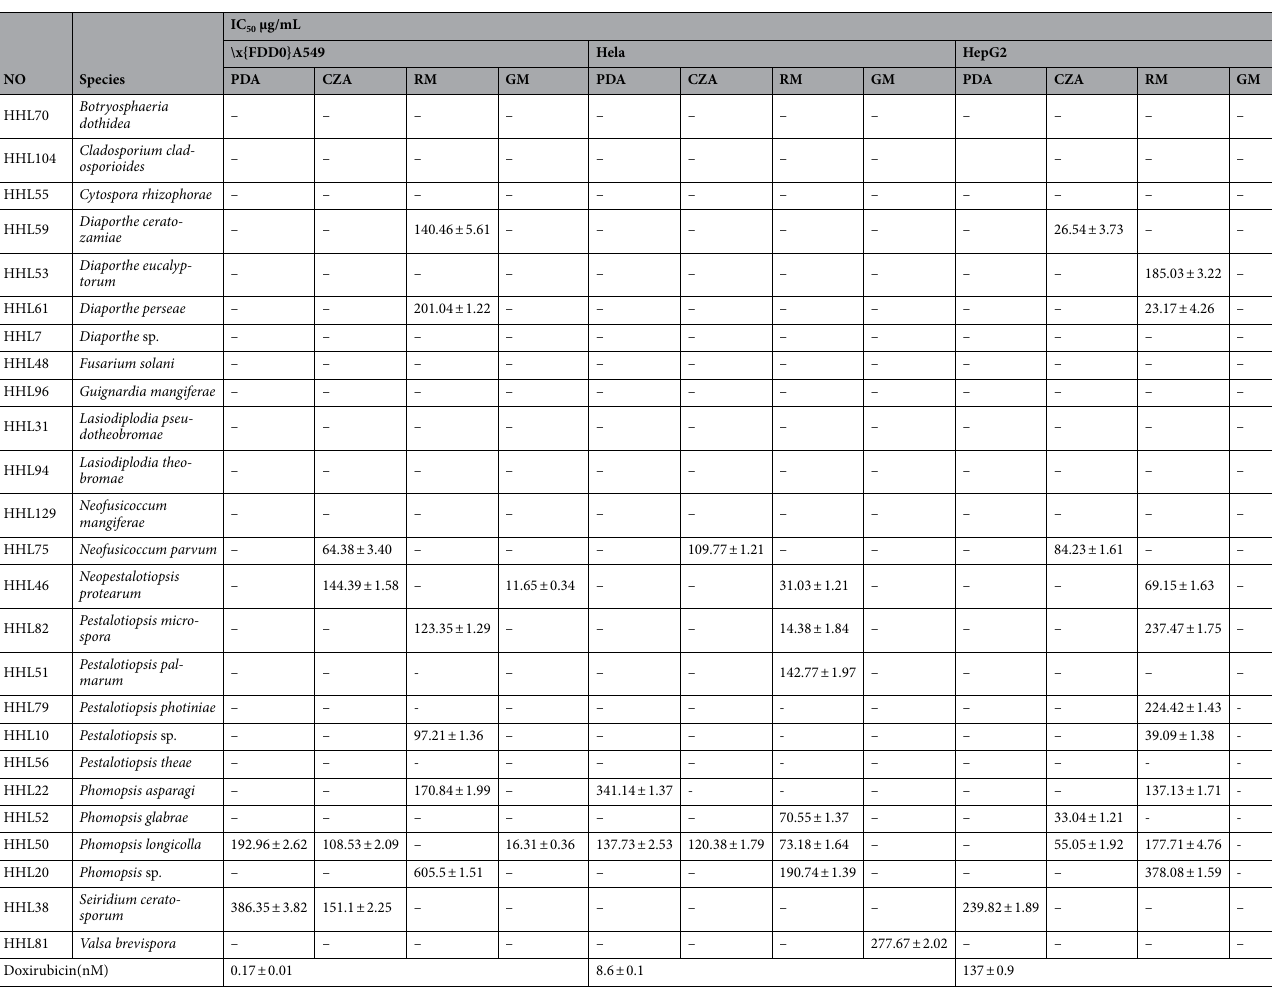
Table 3. Anti-tumor activity of endophytic fungi from R.